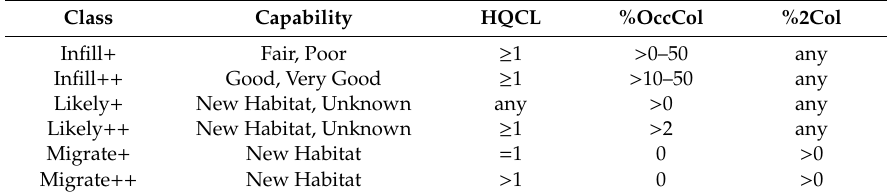
Table 2. Criteria for classes of Infill, Likely, and Migrate, according to the HQ and CL outputs. Capability and HQ-CL are determined separately for RCP 4.5 and RCP 8.5. %OccCol pertains to the percentage of the unit that is either already occupied or with at least a 50% probability of becoming potentially occupied (according to SHIFT) within 100 years. %2Col pertains to the percentage of the unit not already occupied that has at least a 2% probability of getting colonized within 100 years. Class Capability HQCL %OccCol %2Col Infill + Fair, Poor ≥ 1 > 0–50 Good, Very Good ≥